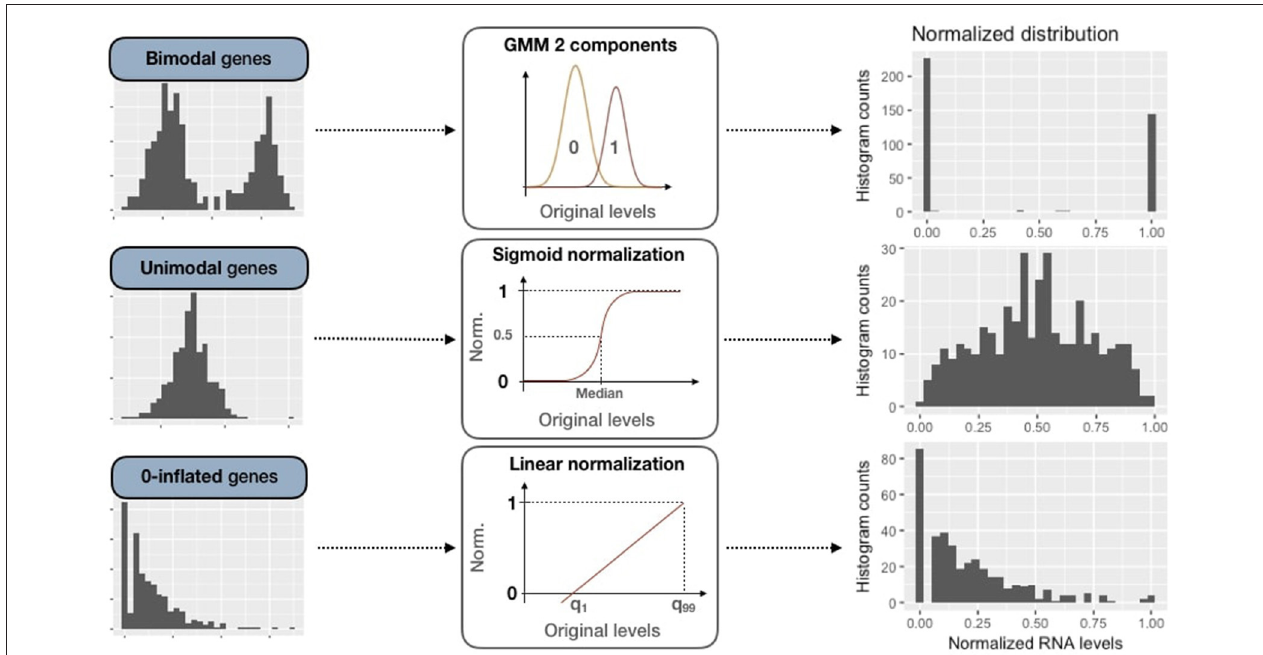
FIGURE 4 | Normalization methods for expression data of genes of all three categories (bimodal, unimodal and zero-inflated). First column panels show examples of original patterns from the three categories. Second column panels illustrate the processing methods used for normalization (GMM 2-component, sigmoid normalization and linear normalization). Third column panels correspond to normalized